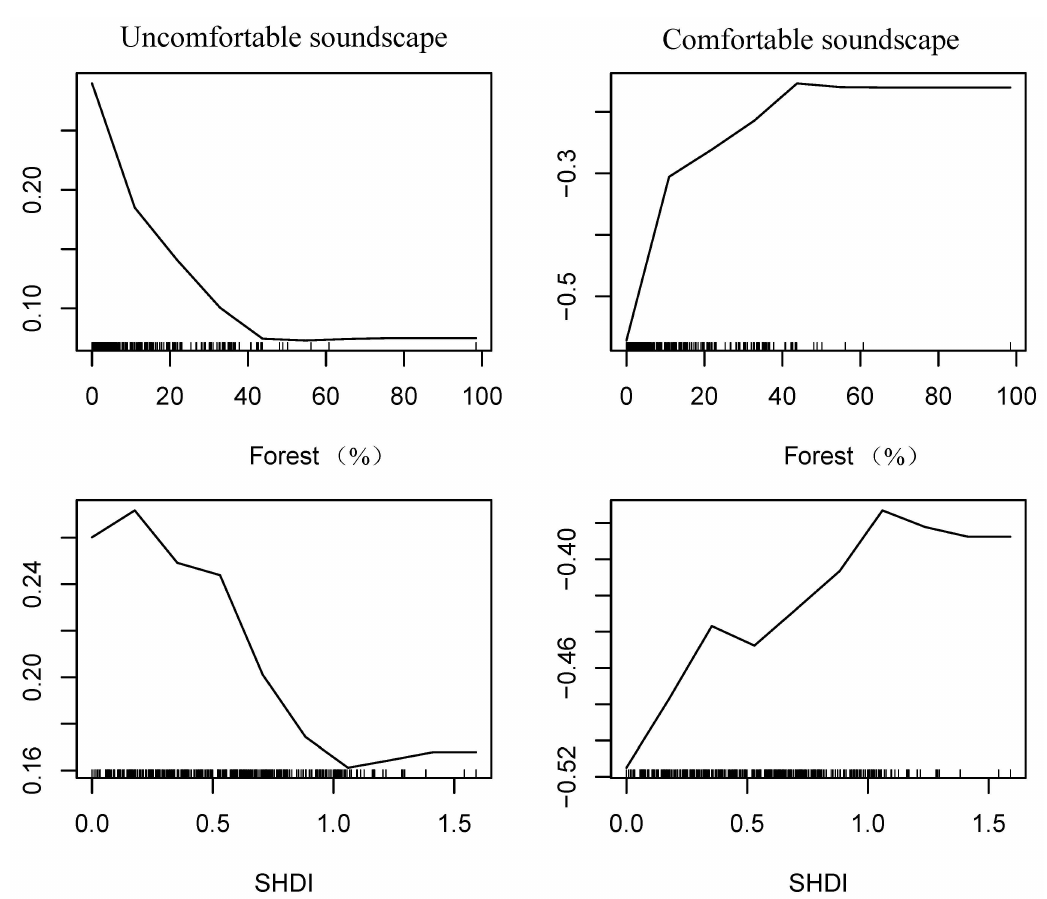
Figure A4. Partial dependence plot to understand the marginal effect of a single predictor on model prediction